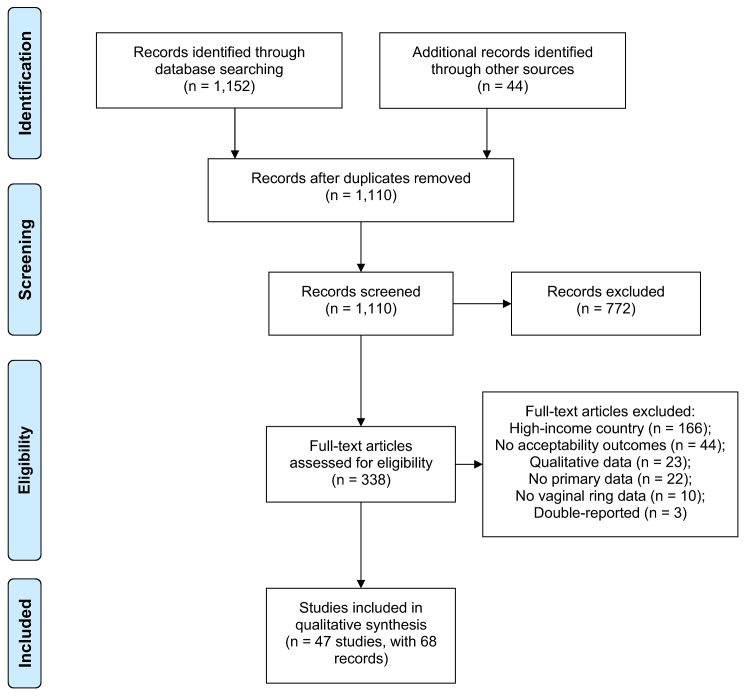
PRISMA flow diagram.